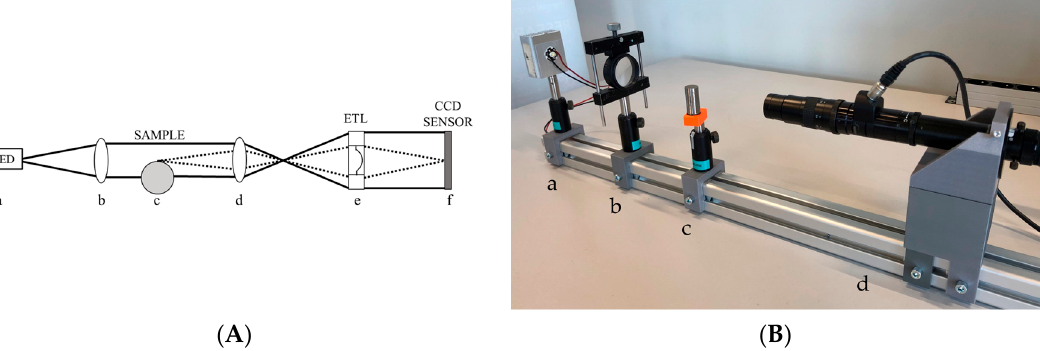
Figure 2. Measurement system setup. ( A ) is a schematic of the instrument composed as follows: (a) LED light, (b) lens, (c) test sample, (d) dynamic focus lens, (e) electrically tunable lens (ETL), (f) “2/3” CCD camera sensor. The black lines represent the light rays from the LED to the sensor, while the dashed lines are from an image point on the focus plane to the sensor. ( B ) is an image of the actual measurement setup: (a) LED light, (b) lens, (c) test sample, (d) objective.